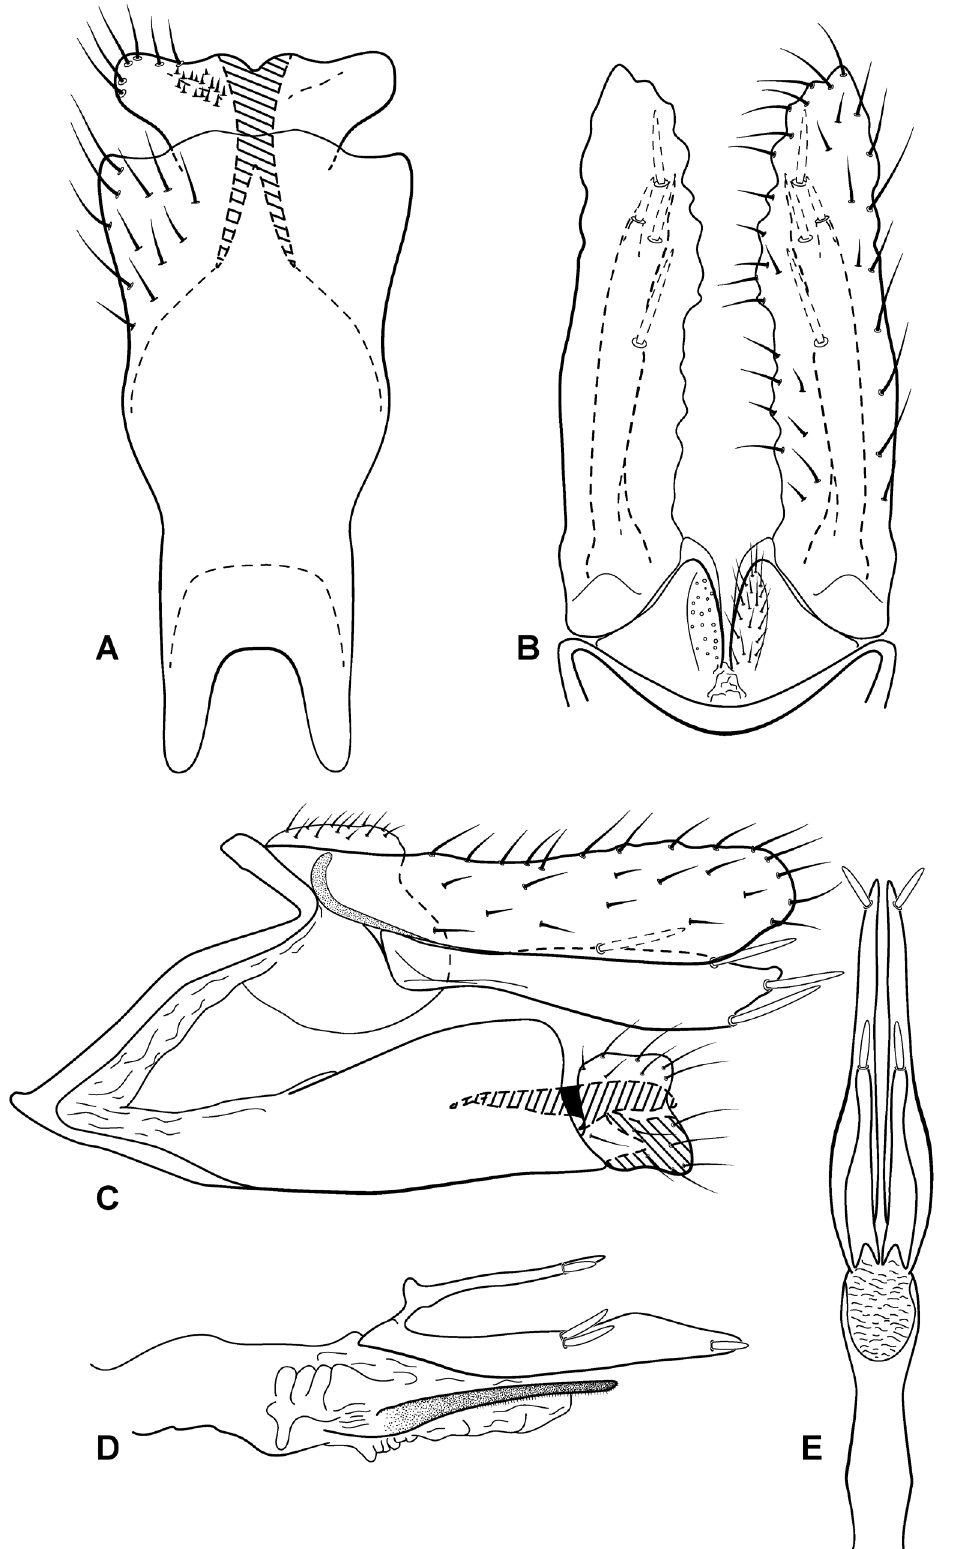
Fig. 13. Austrotinodes vitalbrazili sp. nov., male genitalia. A . Ventral view. B . Dorsal view. C . Left lateral view. D . Phallic apparatus, left lateral view. E . Phallic apparatus, dorsal